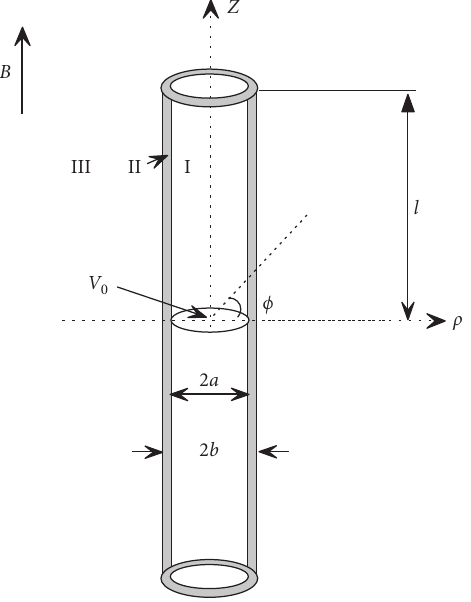
Figure 1: Schematic diagram of an insulated linear antenna in an anisotropic ionosphere.